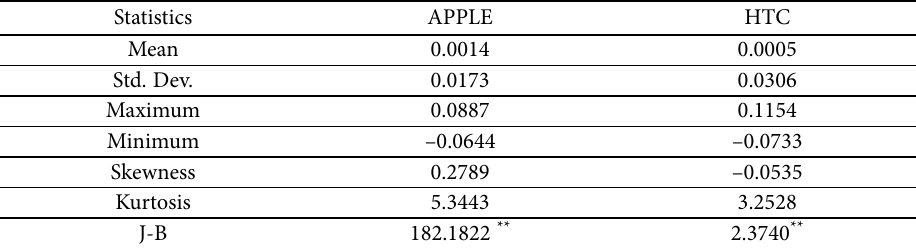
Fig. 2. The trend graph of Apple & HTC stock Table 1. Basic statistics for Apple & HTC stock returns